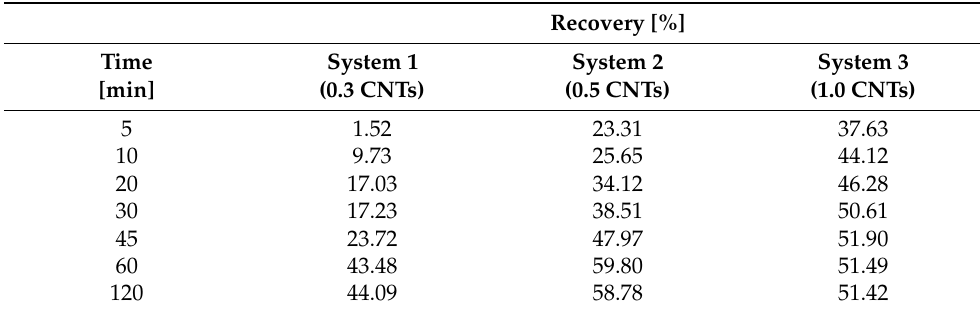
Table 1. Percentage removal of biophenols with respect to the initial quantity of polyphenols present in the OVWs.